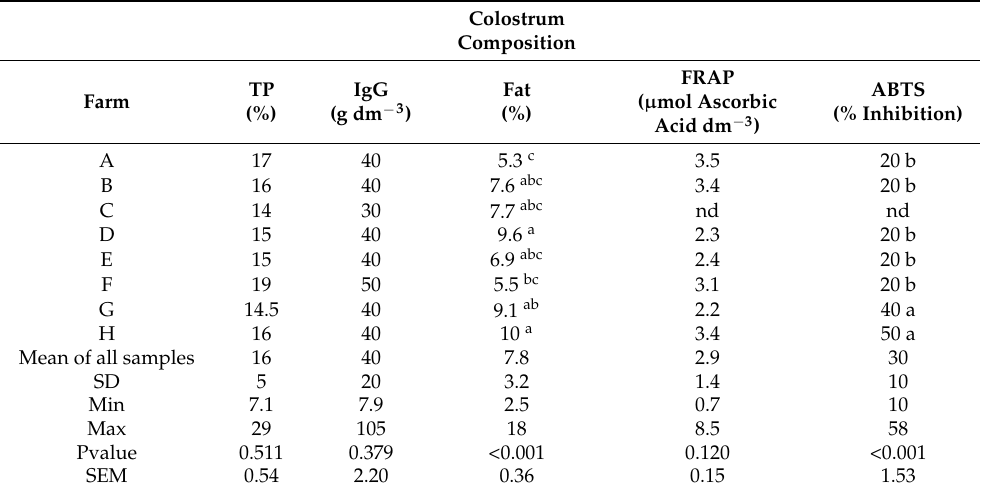
Table 1. Total protein, fat, IgG content, and antioxidant properties of colostrum sampled in eight farms.